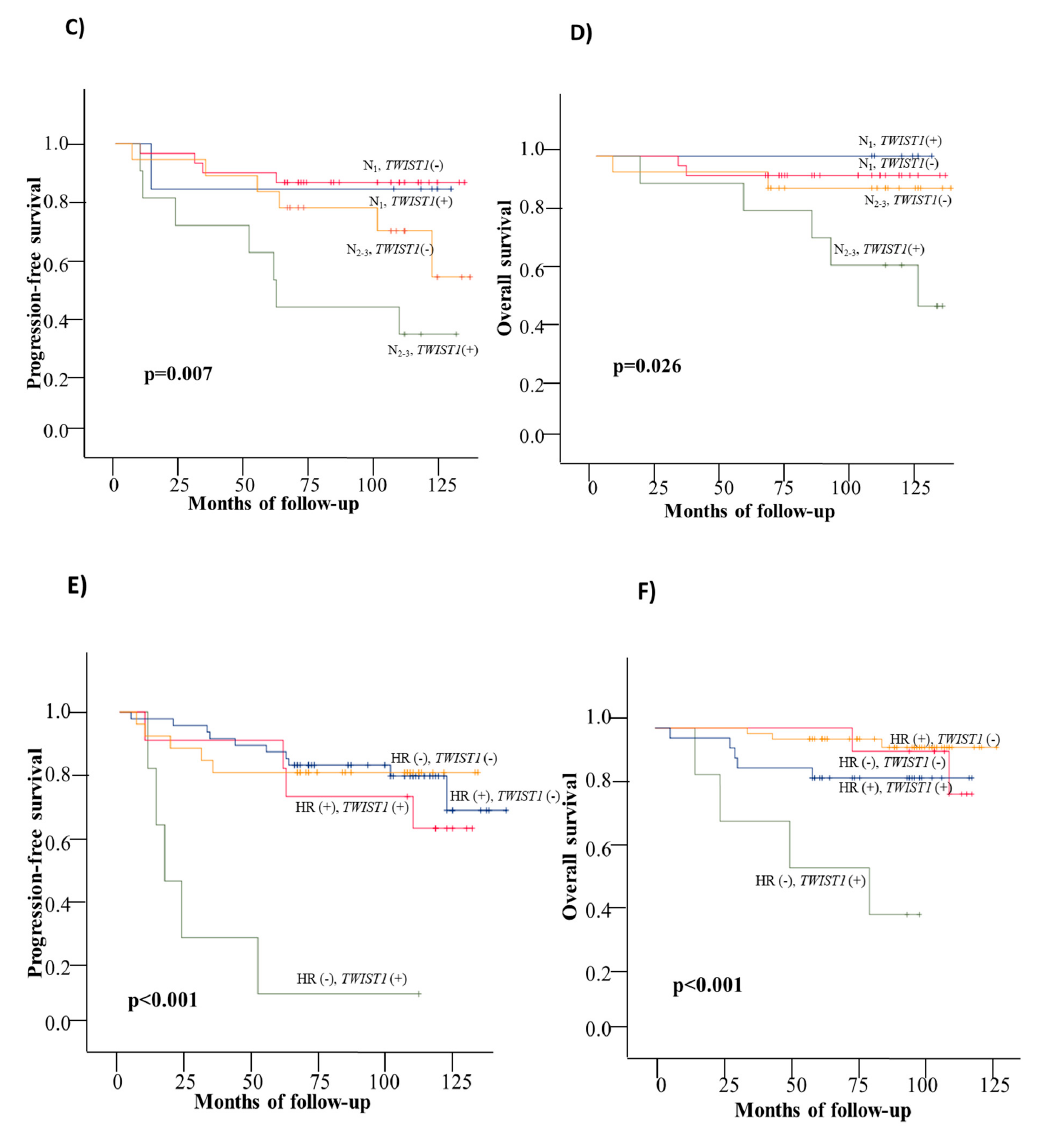
Figure 3. Kaplan–Meier estimates for early BrCa patients: ( A ) DFI: TWIST1 overexpression, ( B ) OS: TWIST1 overexpression, ( C ) DFI: TWIST1 overexpression and number of affected lymph nodes, ( D ) OS: TWIST1 overexpression and number of affected lymph nodes, ( E ) DFI: TWIST1 overexpression and HR status, ( F ) OS: TWIST1 overexpression and HR status. Table 1. Correlation between TWIST1 and CD44 high /CD24 − /low and ALDH1 high /CD24 − /low expression in early breast cancer EpCAM positive samples ( n = 100).